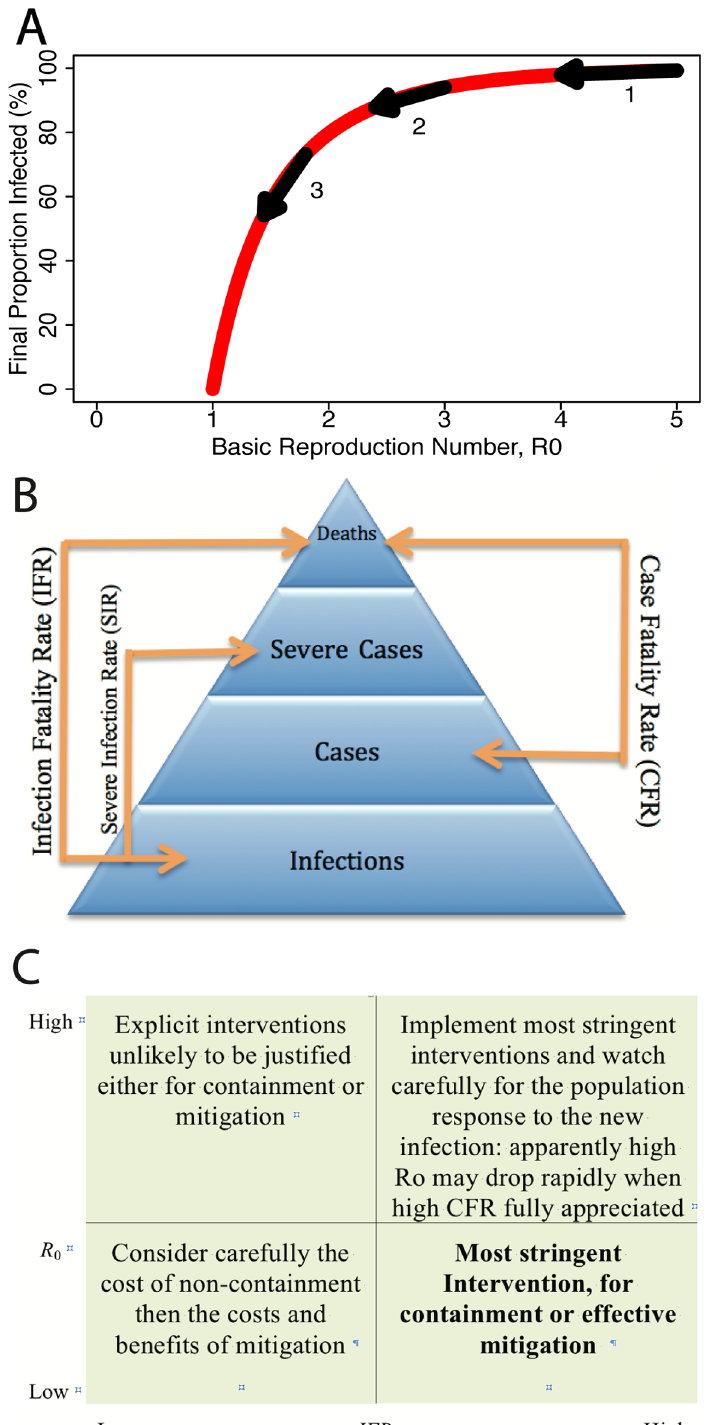
Fig 1. Transmissibility and severity of pandemic influenza. a Relationship between the total number of individuals infected and the basic reproductive number R 0 . Arrows show the non-linear effect of a 20% reduction in transmission: at lower reproductive numbers, the same intervention is much more effective. b Severity pyramid for infectious disease. The strength of symptoms and ability to detect cases increases with each level in the pyramid. c Conceptual two-dimensional classification of pandemics in terms of basic